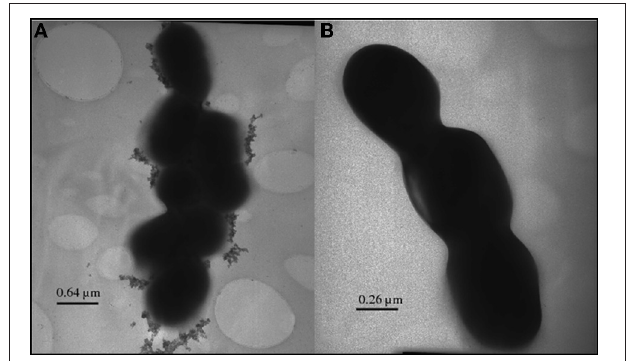
FIGURE 5 | Inorganic selenium granules displayed by TEM on the surface of a selenium-fixing Lactobacillus reuteri strain.